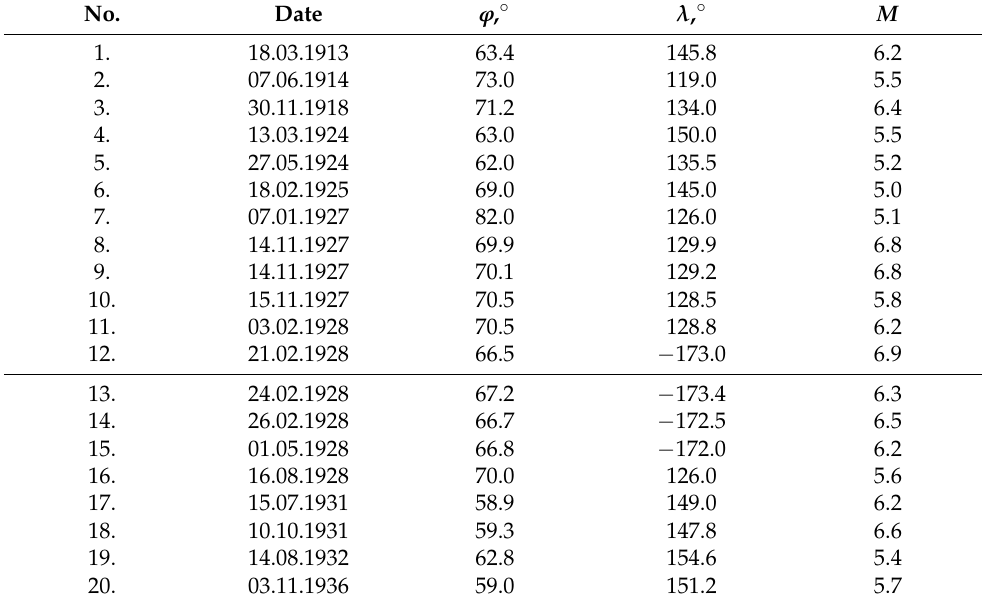
Table 1. The catalog of earthquakes with M ≥ 5.0 in the eastern sector of the Russian Arctic